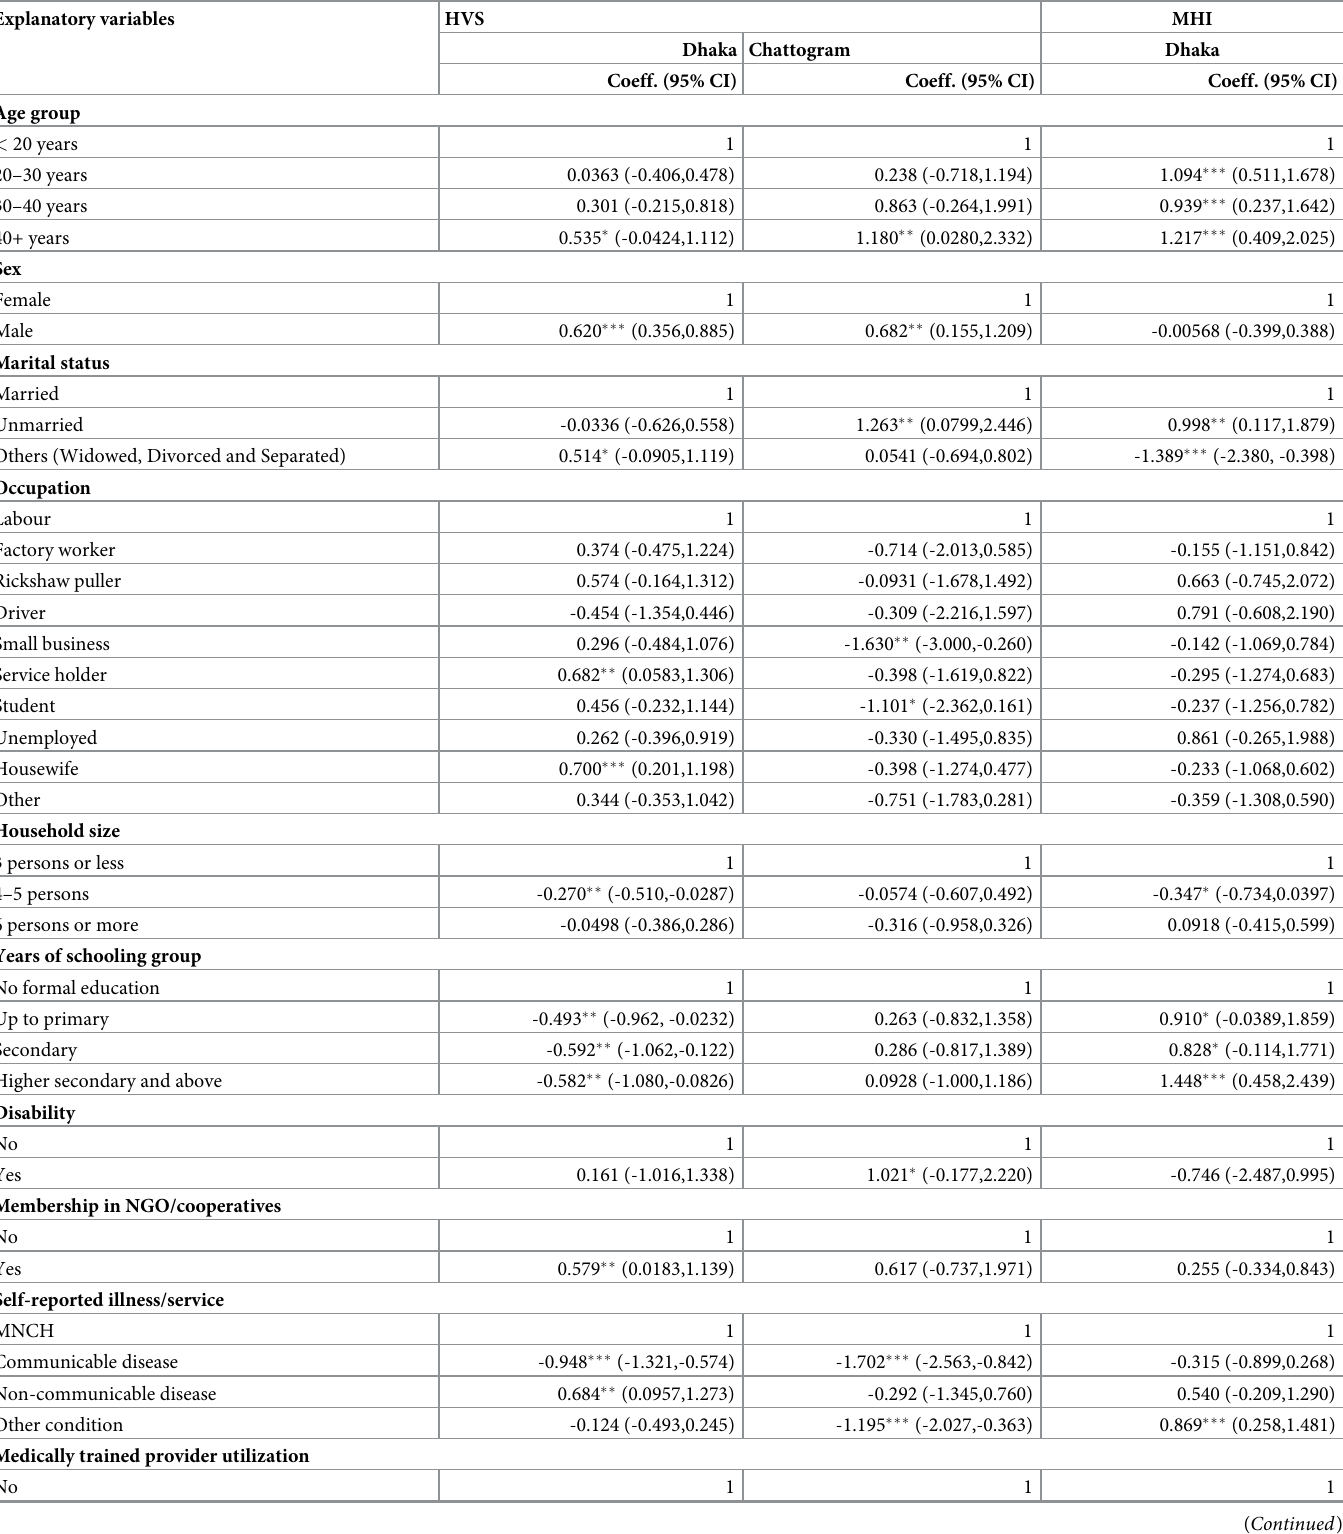
Table 7. Factors of out-of-pocket (logged) payments by health schemes. Explanatory